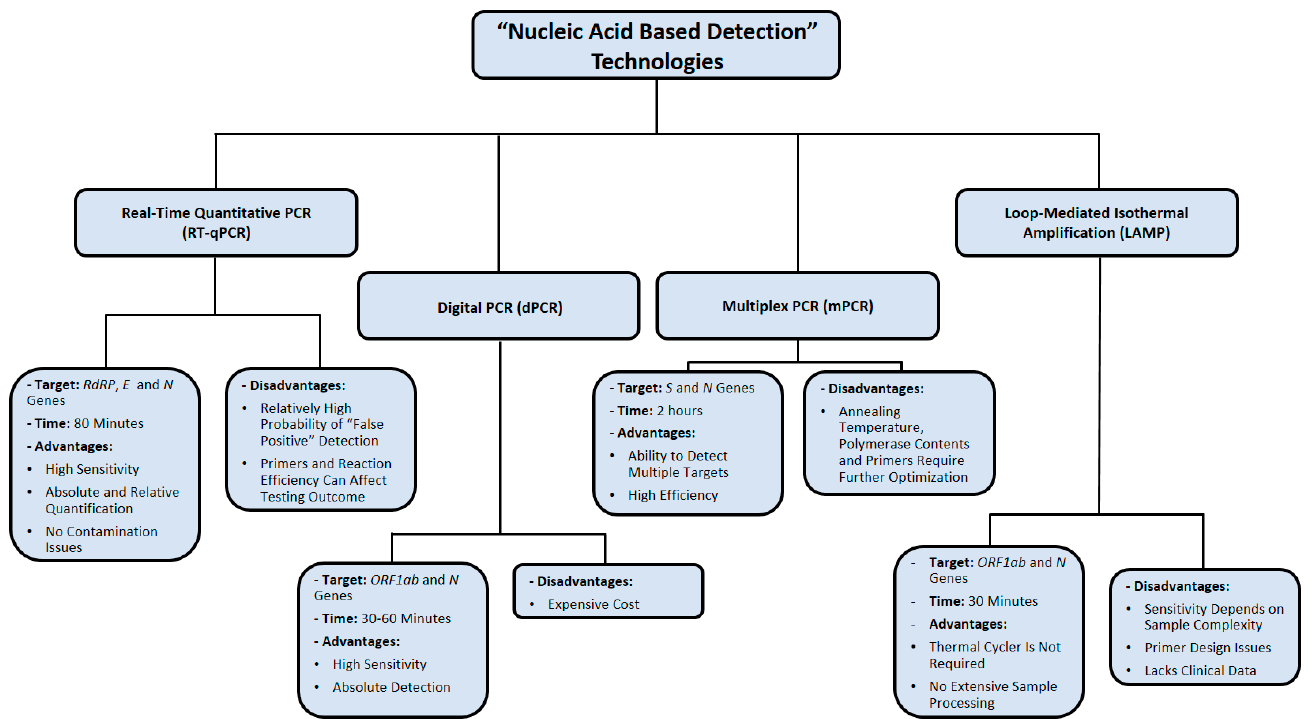
Figure 3. Summary of nucleic acid amplification technologies used in diagnosing SARS-CoV-2 infection. Data were ob- tained from several published reports [17–19,22,34–37,52–55,66–69].